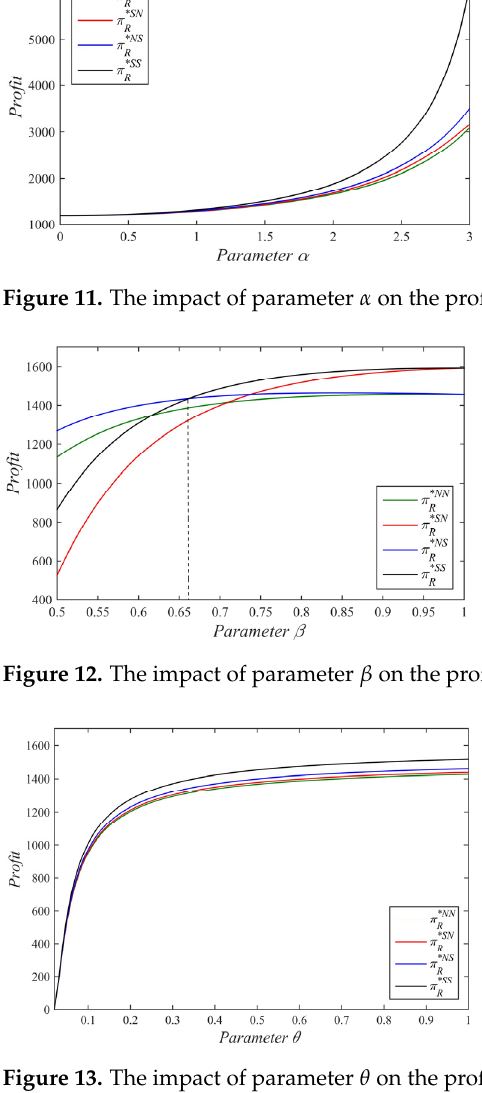
Figure 13. The impact of parameter θ on the profits of